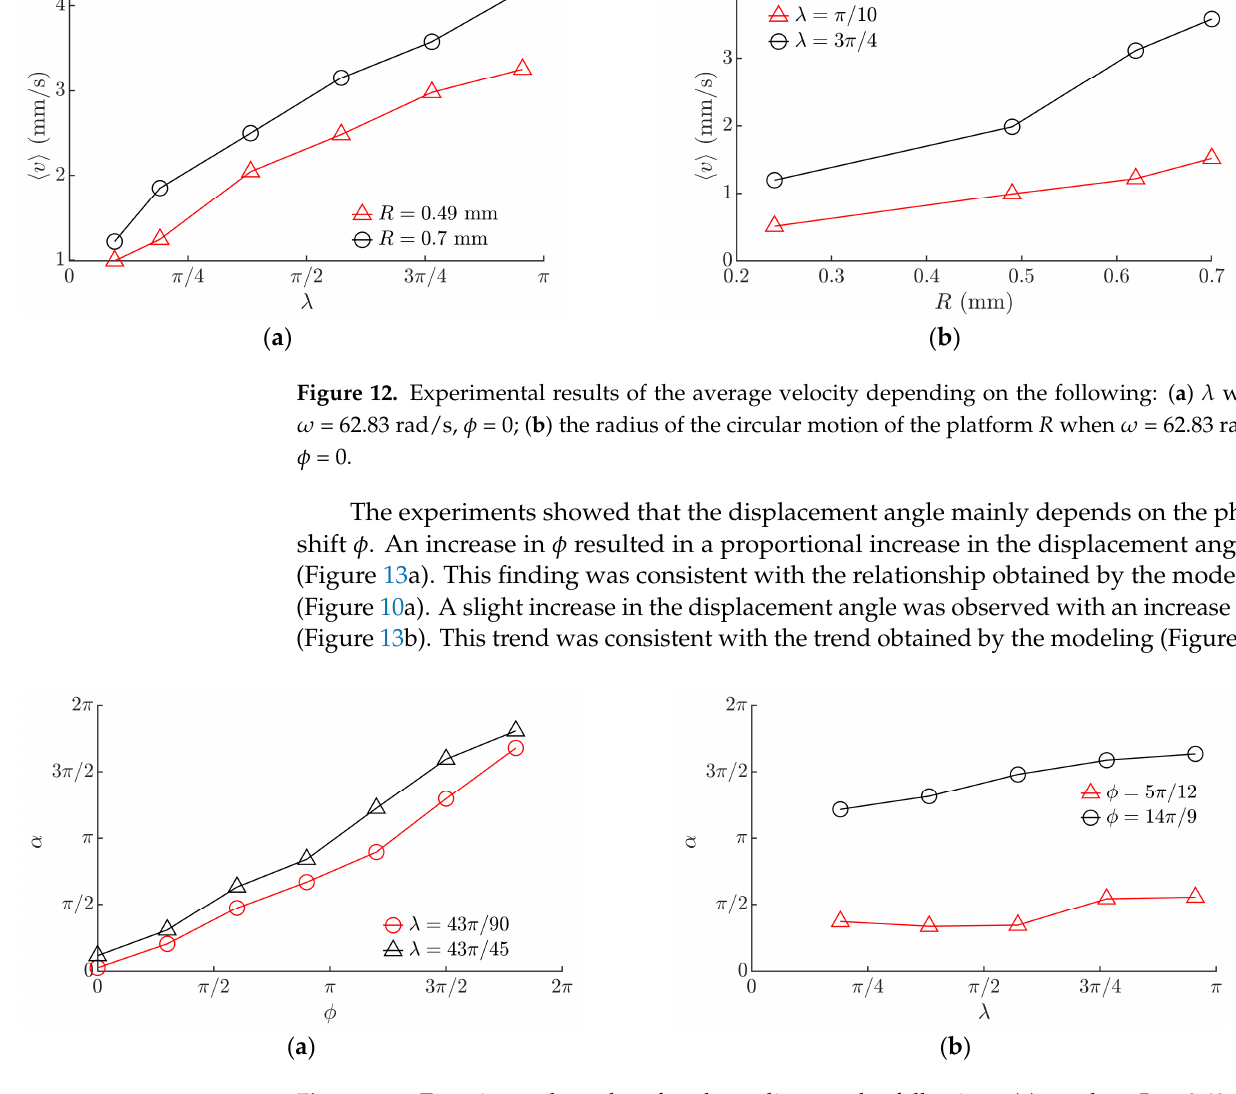
( b ) Figure 14. Images captured during the experiments: ( a ) captured trajectory of a single 0603-type MLCC when R = 0.49 mm, ω = 62.83 rad/s, ϕ = 9 π /5, λ = 43 π /90; ( b ) two frames separated by a time interval of 0.792 s that were captured during the manipulation of multiple 0603-type MLCC when R = 0.49 mm, ω = 62.83 rad/s, ϕ = 9 π /10, λ = 43 π /45. The experiments have shown that the proposed method can be applied for the ma- nipulation of an individual particle or multiple particles. Figure 14b shows two frames separated by a time interval of 0.792 s that were captured during the manipulation of multiple 0603-type MLCC. The motion of a single 0603-type MLCC on the manipulation plate is demonstrated in Supplementary Material Video S1. The motion of multiple MLCCs on the manipulation plate is demonstrated in Supplementary Material Video S2. 4. Conclusions A method for omnidirectional manipulation of microparticles on a platform sub- jected to circular motion is proposed, which is achieved by applying dynamic dry friction control. In order to determine the intrinsic parameters of the system that define the direction and velocity of particles, a nondimensional mathematical model of the proposed method was developed. Modeling of the manipulation process applying dynamic dry friction con- trol was carried out. The modeling has revealed that the motion of a particle can be achieved and controlled through the asymmetry created by dynamic friction control. An asymmetry necessary to achieve the particle’s motion can be created when the effective